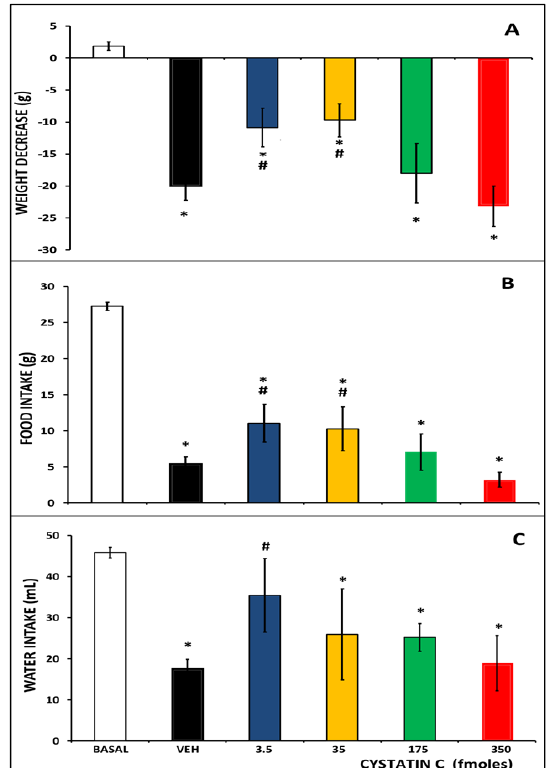
Figure 1. Effect of CC administration before TBI on weight decrease, food and water intake. ( A ) Bars represent mean ± SEM of weight (g) measured 24 h after TBI; ( B ) Bars represent mean ± SEM of food intake (g) 24 h after TBI; ( C ) Bars represent mean ± SEM of water intake (mL) 24 h after TBI. * p < 0.05 vs . basal, # p < 0.05 vs. veh; One-way ANOVA and Duncan’s test as post hoc